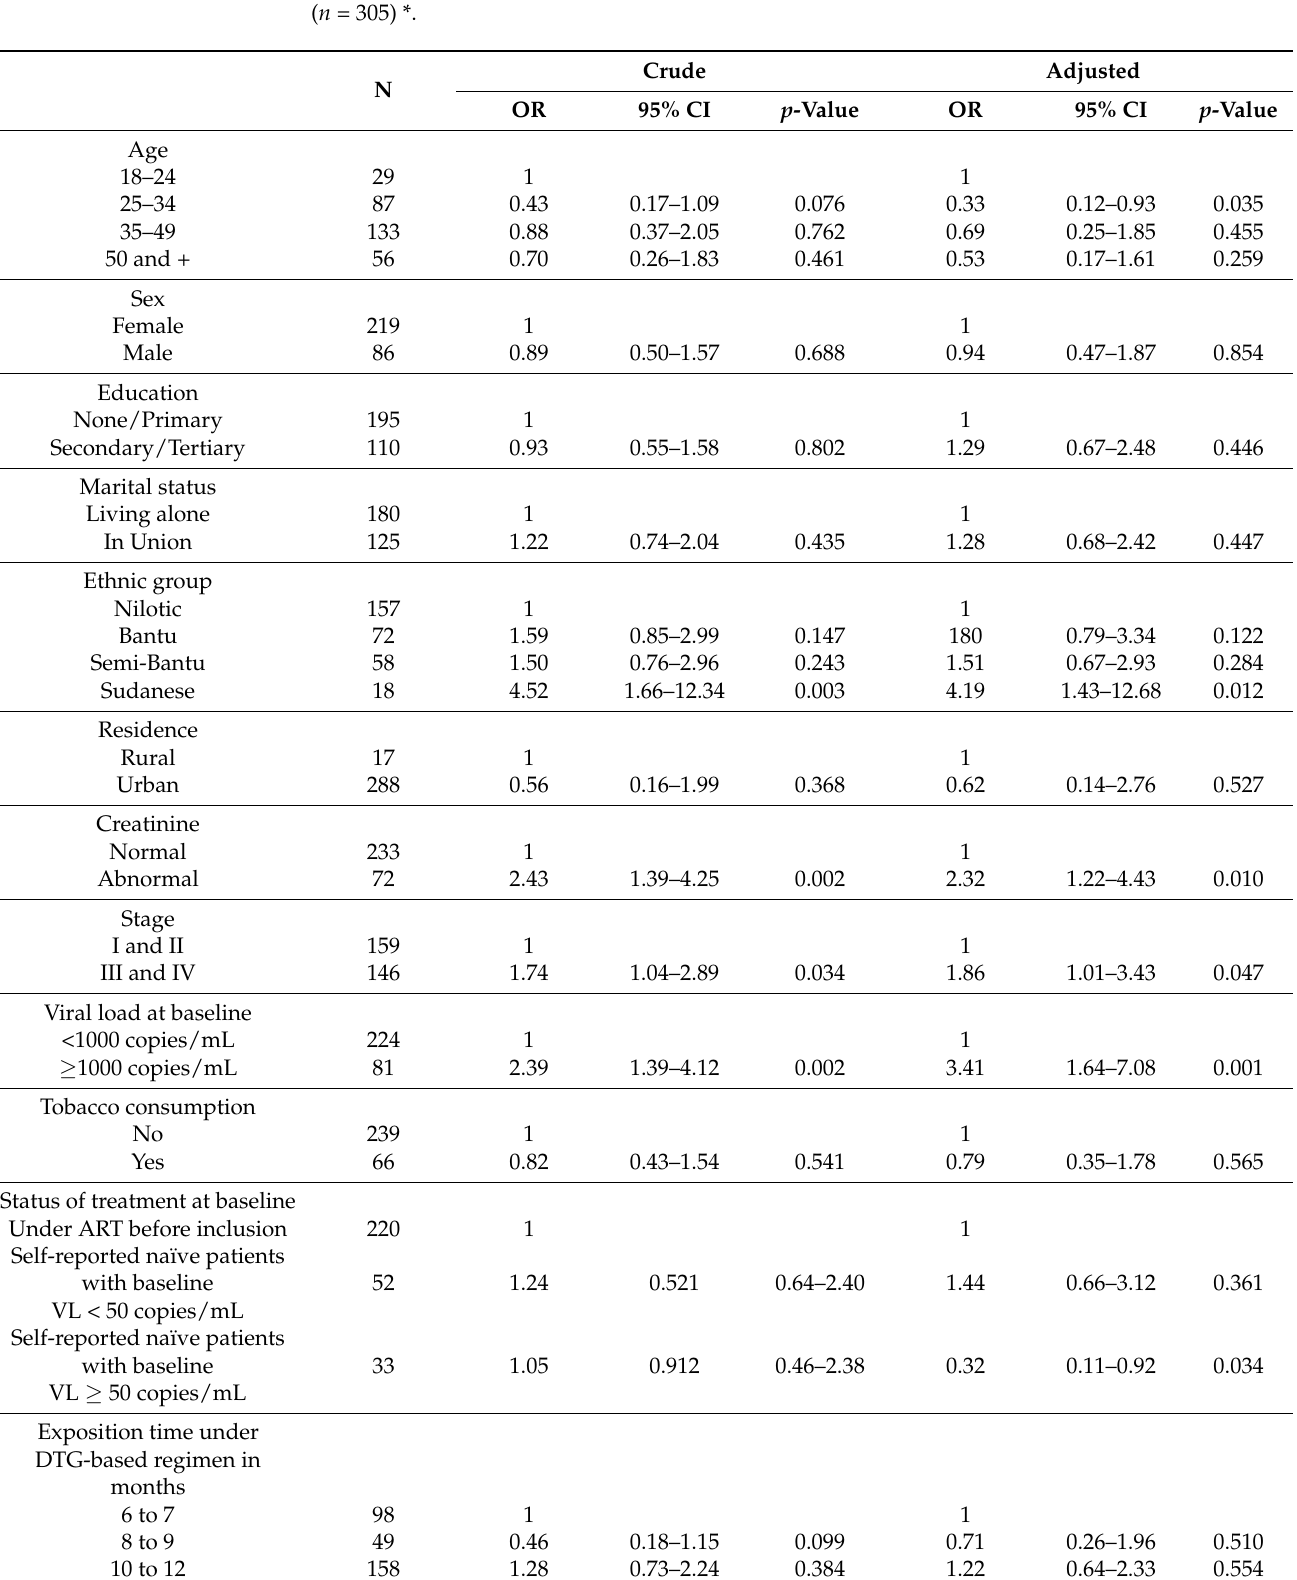
Table 3. Predictors of virological non-suppression among patients living with HIV under dolutegravir ( n = 305)